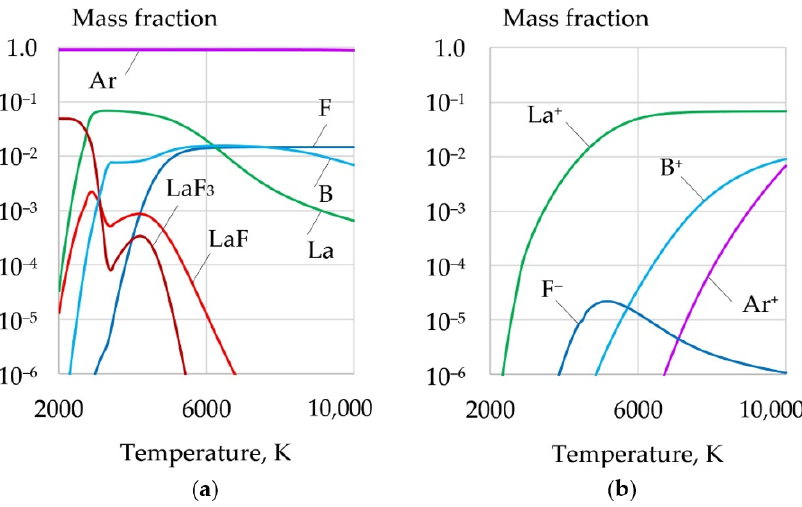
Figure 4. Mass fraction of components during dissociation ( a ) and ionization ( b ) of the mixture, wt.%: 90Ar + 5LaF 3 + 5LaB 6 .